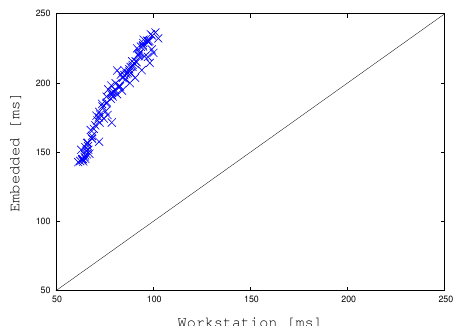
Figure 17. Reference algorithm: Comparing running times on the desktop workstation against the ones gathered on the embedded system.